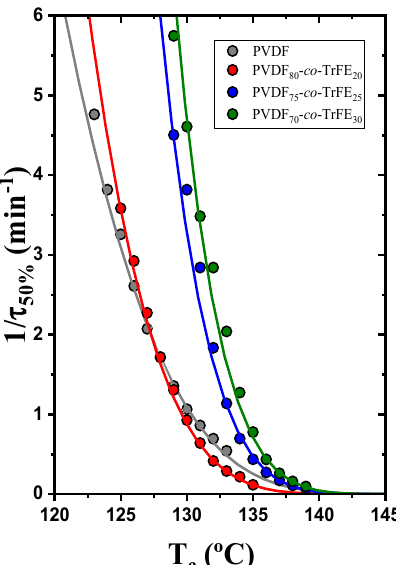
Figure 5. Inverse of the half crystallization time for neat PVDF and copolymers at different compositions as a function of the isothermal crystallization temperature.